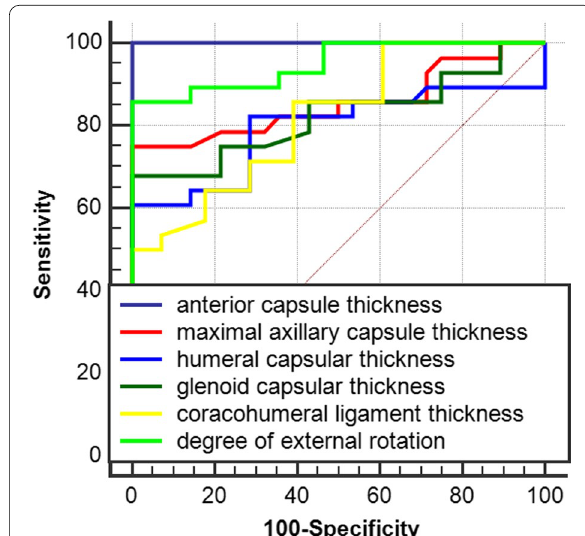
Fig. 5 ROC curve analysis for quantitative